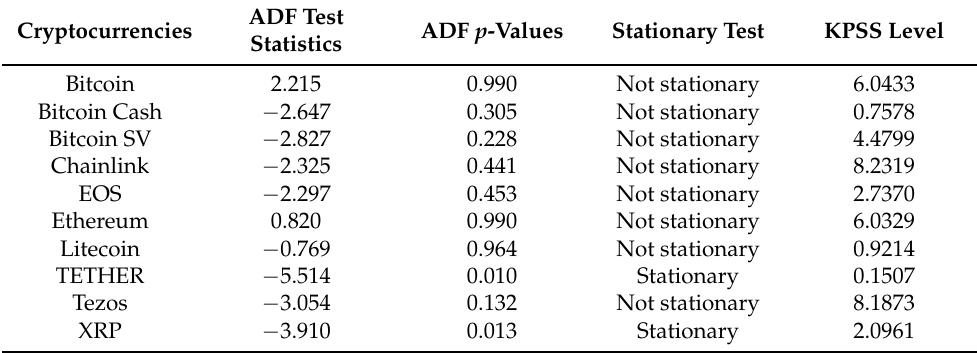
Table 2. Tests of stationarity characteristics of each